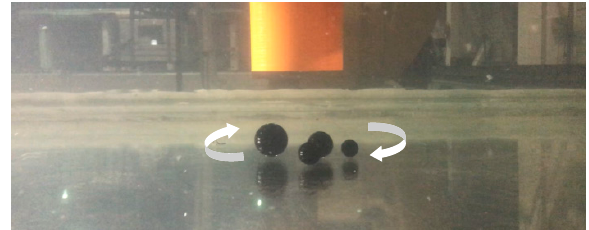
Figure 16. A snapshot of multiple particles with circular motion.